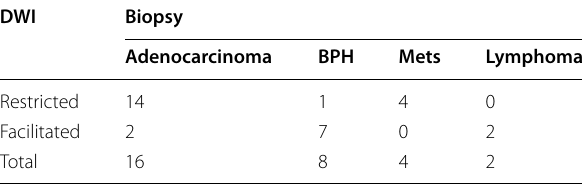
Table 3 Showing biopsy results compared to DWI